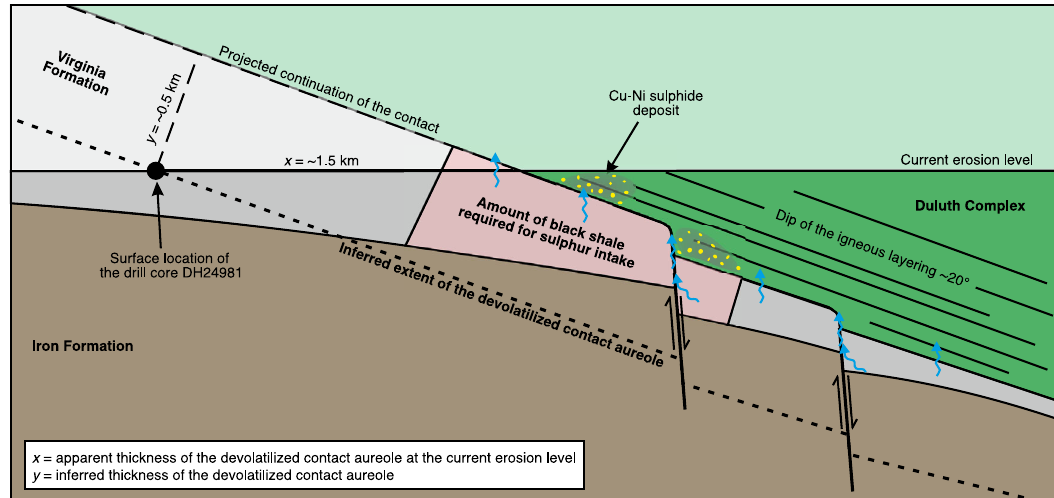
Fig. 7 In-scale schematic cross-section showing the portion of the Virginia Formation required for the sulphur intake by the Duluth Complex deposits. The location of the cross-section is indicated in Supplementary Fig. 1. The drill core DH24981 bears evidence of kerogen graphitization and replacement of pyrite by pyrrhotite 33 , indicating devolatilization and sulphur mobilization. The intrusive contact was projected upwards from the surface using the 20° dip of the Duluth Complex igneous layering 61 , providing true thickness of 0.5 km for the approximated devolatilized contact aureole. The thickness of the contact aureole exceeds the present thickness of the downwards-tapering Virginia Formation below the Duluth Complex 62 . The proportion of the Virginia Formation required for the sulphur intake by the Duluth Complex Cu – Ni sulphide deposits is equal to a 500 × 750 m rectangle and smaller than the size of the Virginia Formation within the contact aureole. Note that the illustration does not take into account possible sulphur mobilization from xenoliths and the walls of the feeding channel of the